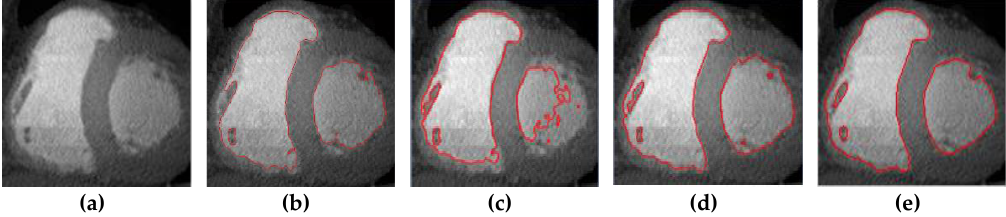
Figure 7. Comparisons of the four models in segmenting the heart image: (a) The original image; (b) The segmentation results of the LSACM model; (c) The segmentation results of the CEM model; (d) The segmentation results of the LHIF model; (e) The segmentation results of the IRLS-IS model.